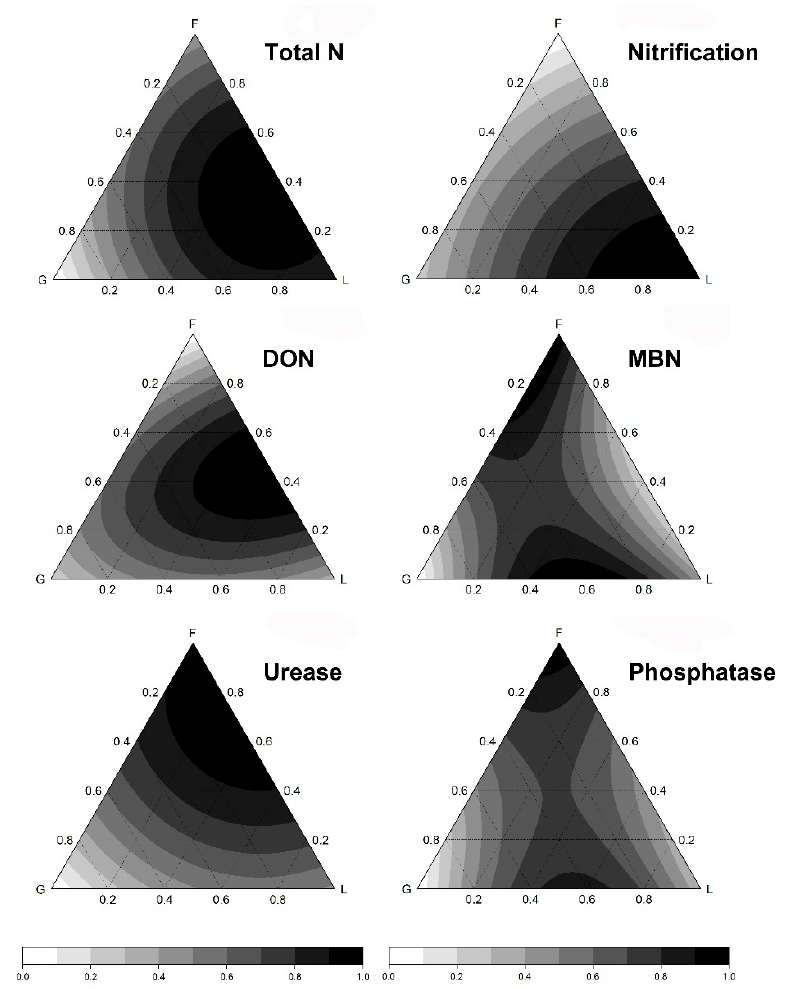
Figure 4. Contour plots representing the variations of soil activity and fertility functions in relation to the relative proportions of the plant functional types (F = forb; L = legume; G = grass) on soil parameters: total nitrogen (total N), nitrification potential, dissolved organic nitrogen (DON), microbial biomass nitrogen (MBN), urease, and phosphatase activities. Contour plots are normalized and scaled from 0, representing the minimum value of the soil parameter, to a maximum of 1. Color intensity shows a gradient from the minimum (white) to the maximum (black) soil activity/fertility parameter.